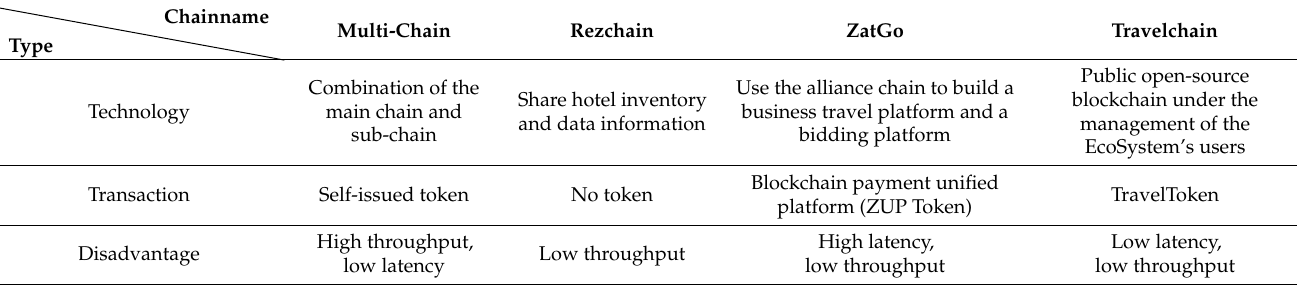
Table 1. Compare the technology and characteristics with the existing tourism